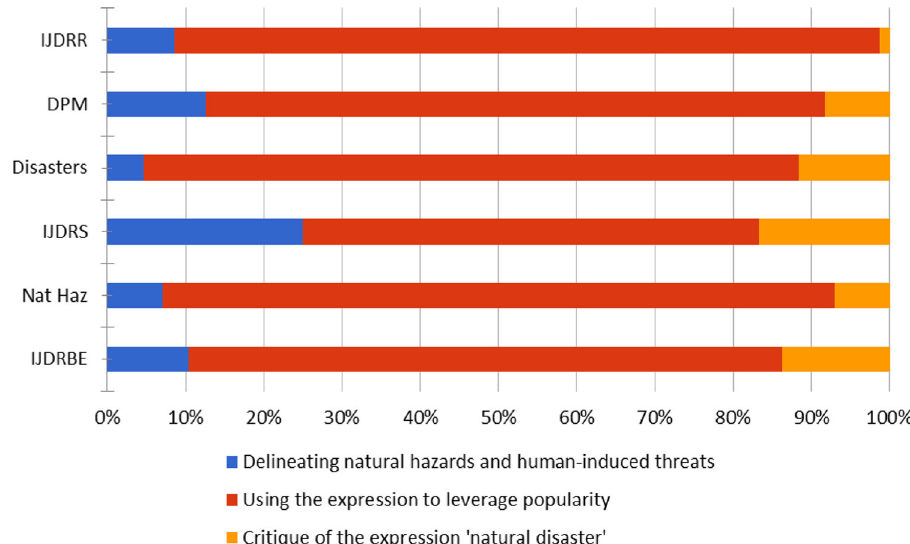
within which the ‘‘natural disaster’’ expression is used in the 589 selected research articles in the six selected academic journals (some articles feature in more than one